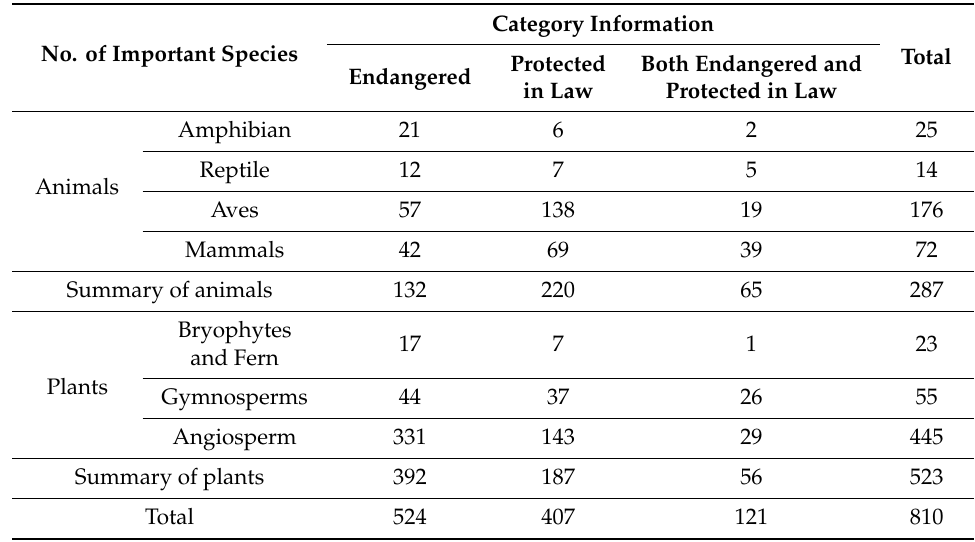
Table A1. Summary of key protected